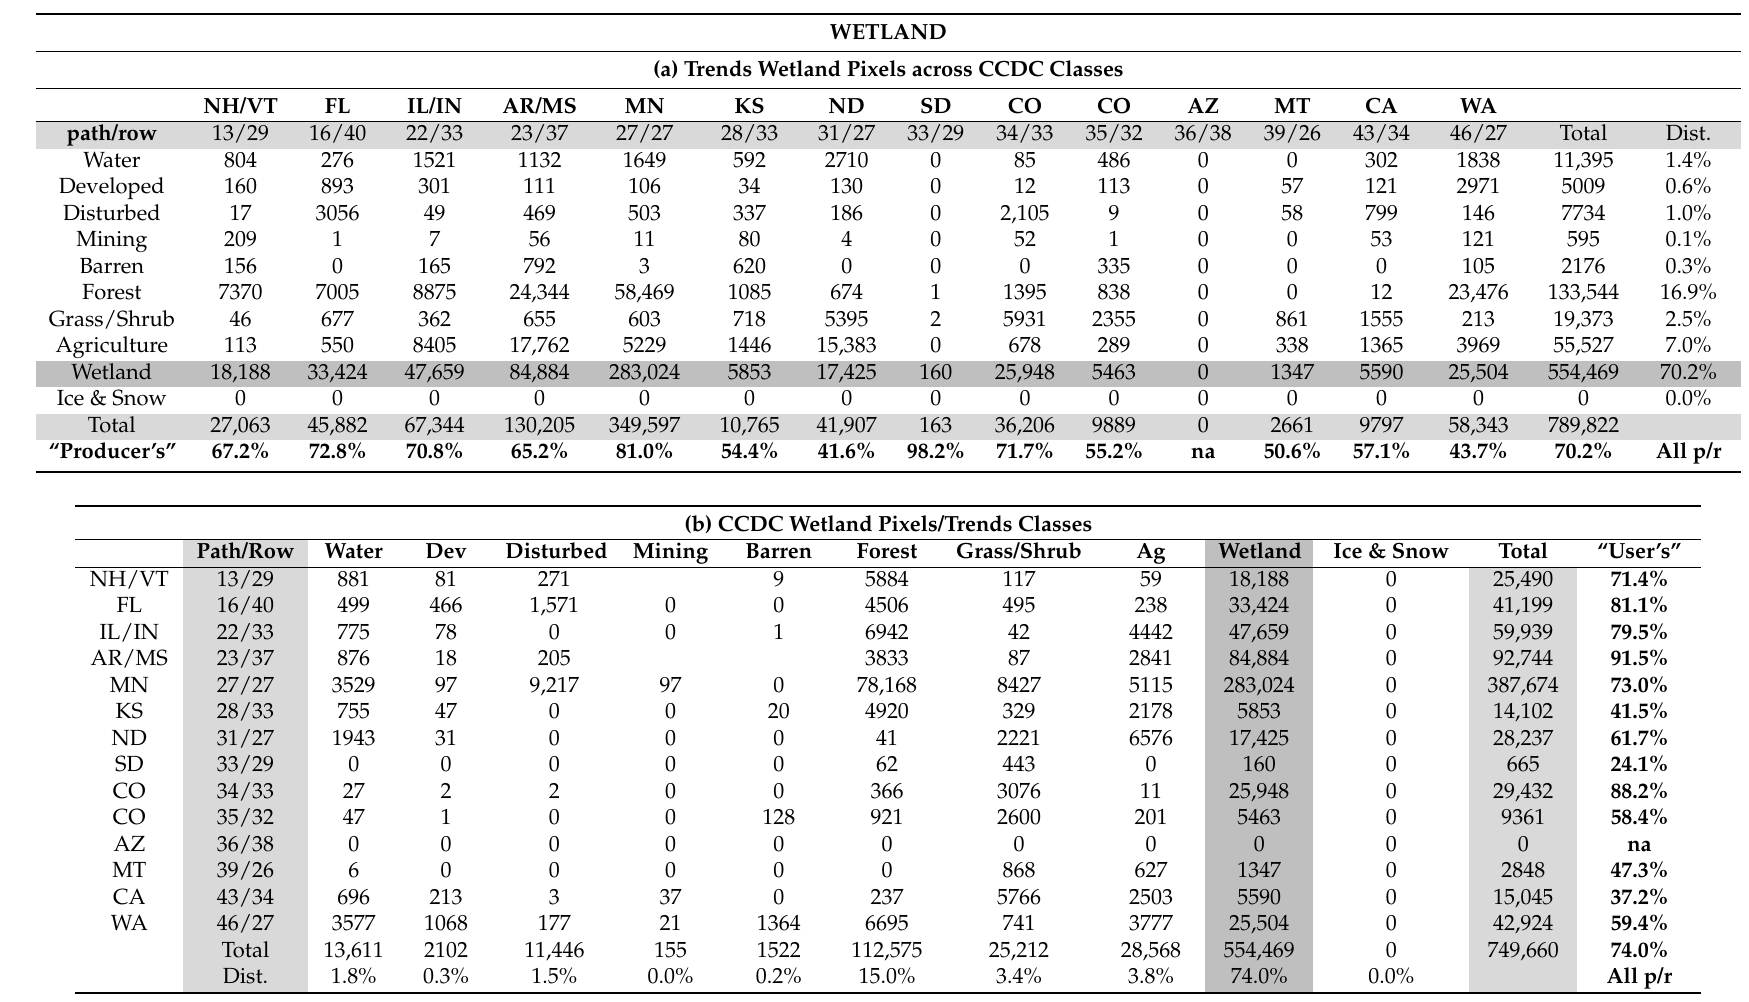
Table 9. (a) LC Trends Wetland pixels distributed across CCDC classes for each path/row location and (b) CCDC Wetland pixels distributed across LC Trends classes for each path/row. AR = Arkansas; AZ = Arizona; CA = California; CO = Colorado; FL = Florida; IL = Illinois; IN = Indiana; KS = Kansas; MN =